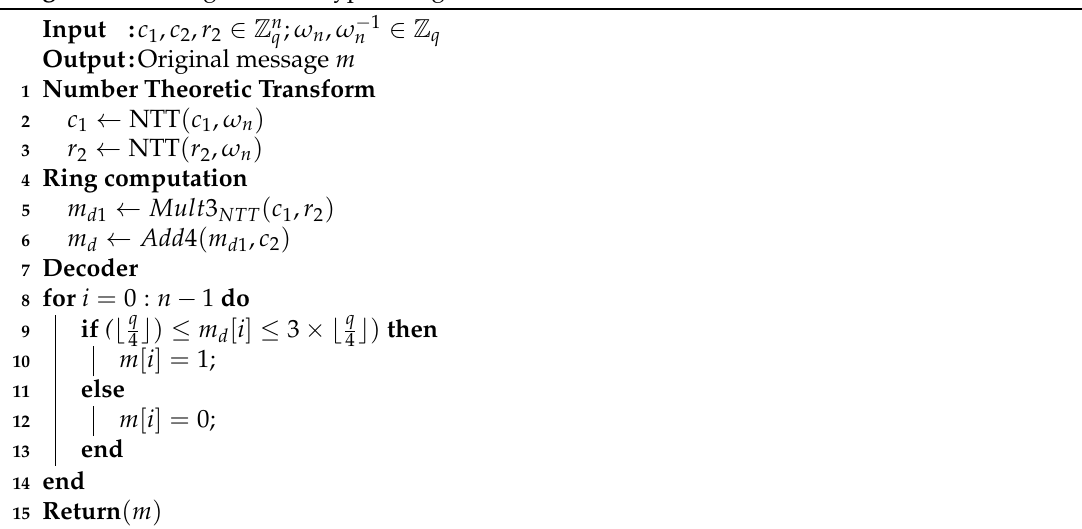
Algorithm 3: Ring-LWE decryption algorithm.